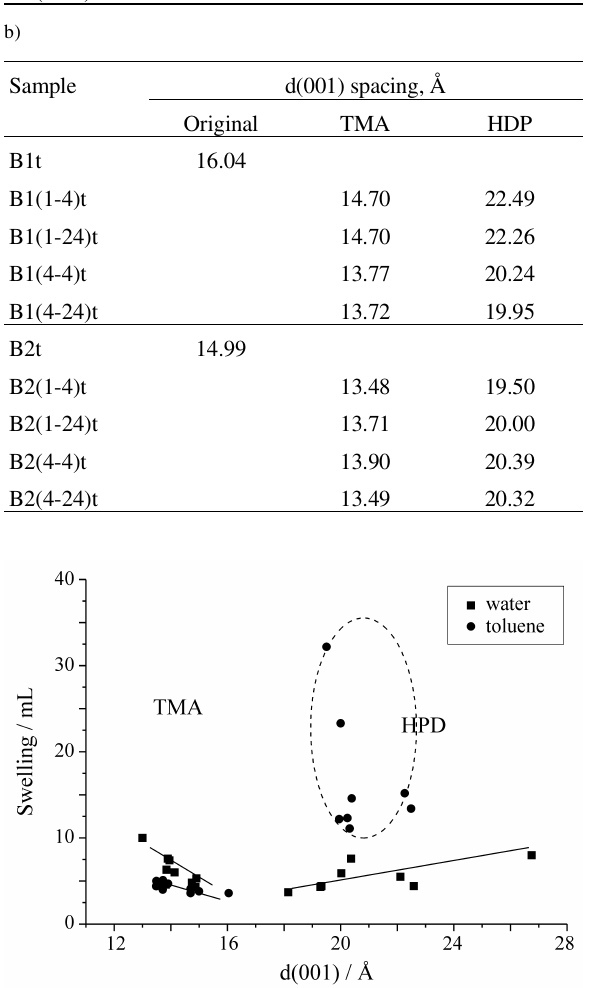
Figure 2. Swelling in water and in toluene media vs. interlayer spacing of